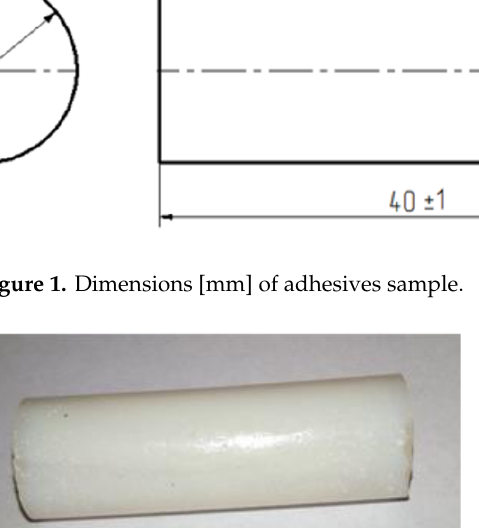
Table 4. Di ff erent, control and modified with calcium carbonate, epoxy compounds produced and analysed in the present study.